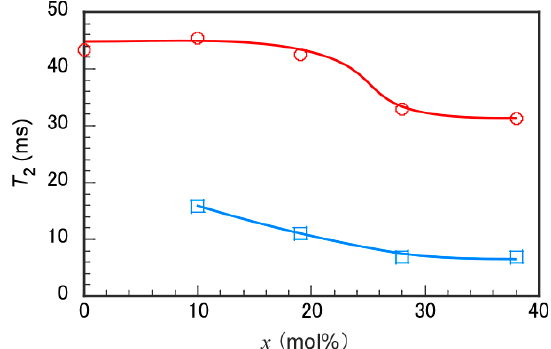
Figure 4. Spin-spin relaxation time ( T 2 ) of the MPC pendant methyl protons at 3.21 ppm ( 〇 ) and the